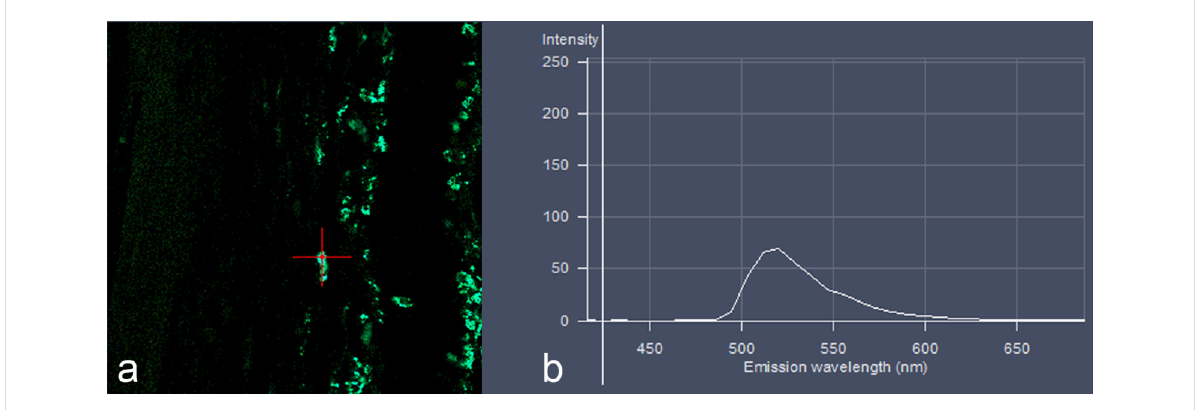
Figure 5: Spectral imaging and linear unmixing detection of green fluorescent SiO 2 -NP (55 ± 6 nm in diameter) in the subcutis of a mouse, indicated by the red cross (a), revealed an emission curve (b) which is highly specific for FITC with an emission maximum between 520 and 530 nm